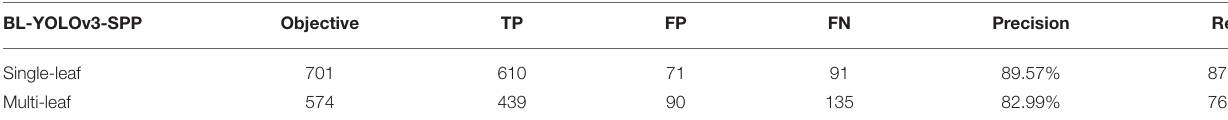
TABLE 5 | The statistical results of the detection of single-leaf and multi-leaf images for test_orchard.